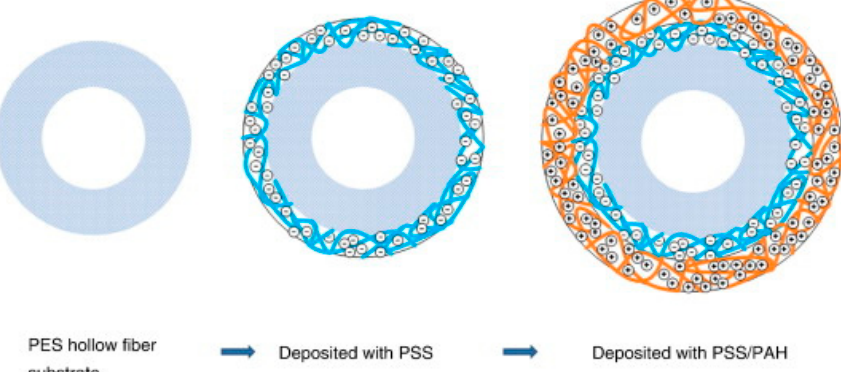
Figure 9. Schematic drawing of multi-layer polyelectrolyte deposition on the outer surface of a hollow-fiber membrane (adapted with permission from [185]).